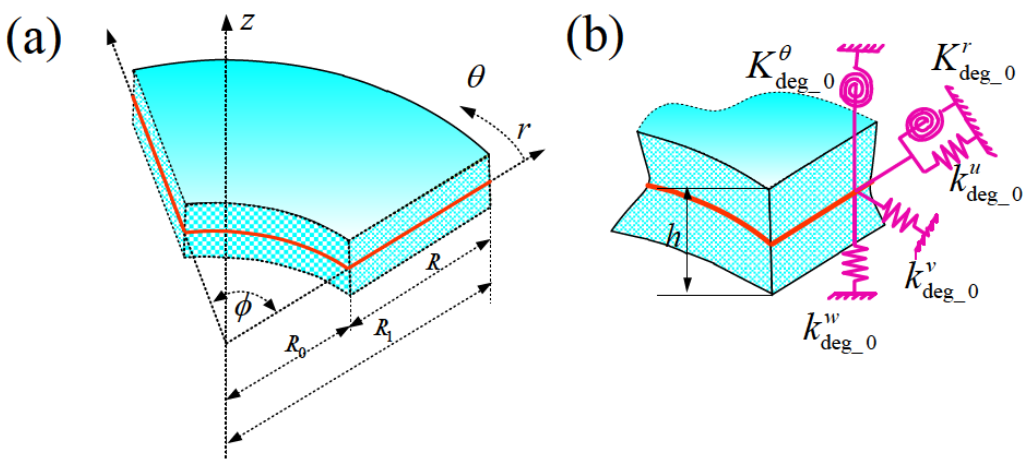
Figure 1: Geometry properties of FG-CNT reinforced composite annular sector plate with elastic supports